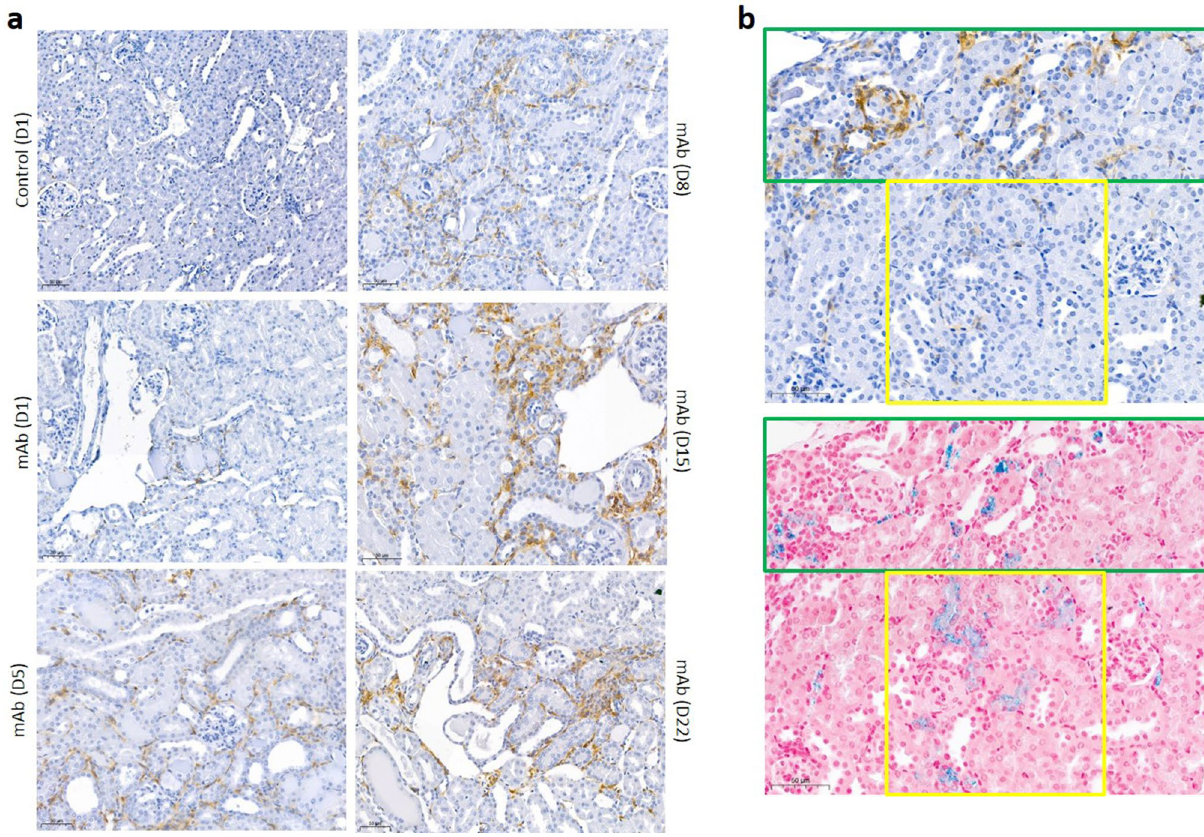
Figure 3. Macrophage influx and iron deposition in mAb-injected mice. Representative images of F4/80 immunostaining (brown) in mAb-injected mice that increased over time ( a ). Representative image of serial sections stained with F4/80 and Perls ( b ). The green square indicates an area of co-localization of macrophages and iron deposition; the yellow square demonstrates an area with only intratubular iron deposition, without macrophage influx. Scalebar = 50